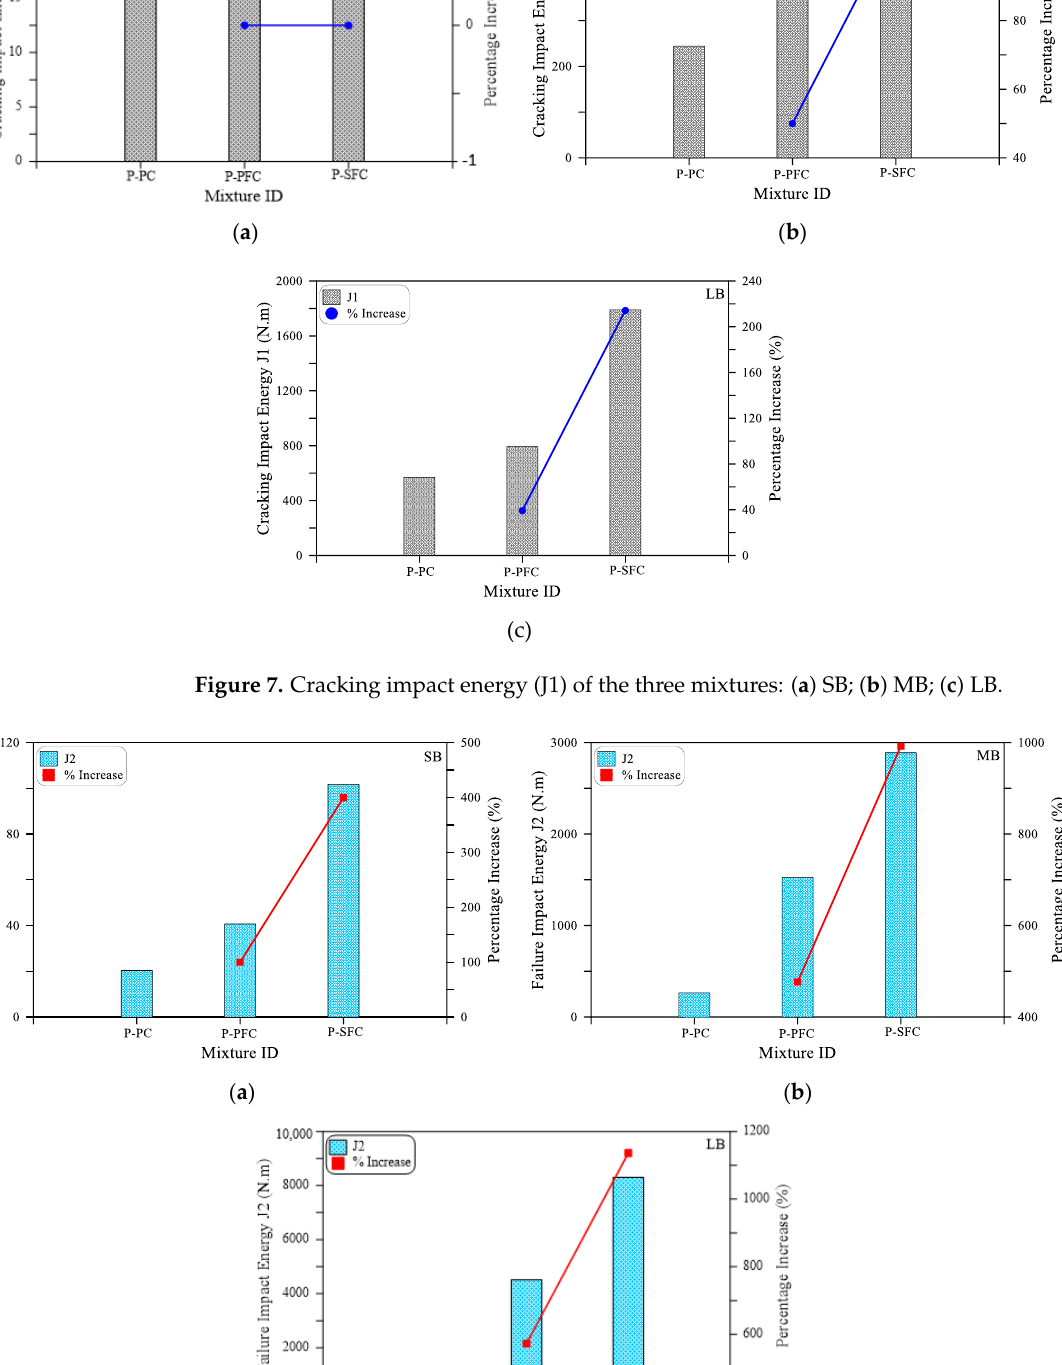
Figure 9. Failed steel fiber-reinforced specimens. ( a ) ( b ) ( c ) Figure 10. Cracking impact energy (J1) of the three beam sizes: ( a ) PC; ( b ) P-PFC; ( c ) P-SFC.